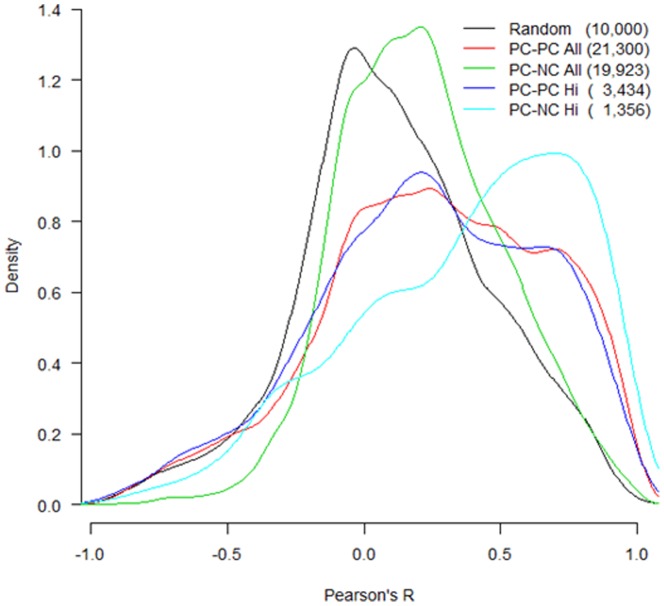
Distribution of correlation R value for expression patterns between pairs of neighboring genes.Random are gene pairs selected at random; PC-PC All means every nearest PC (protein-coding) neighbor for every PC gene; PC-NC All means every nearest PC neighbor for every NC (long non-coding) gene; PC-PC Hi means PC-PC neighbor pairs within 10 kb of each other, and at least one gene in the pair is expressed; PC-NC Hi means PC-NC neighbor pairs within 10 kb of each other, and NC must be expressed. The number of gene pairs in each group is shown in the parenthesis.